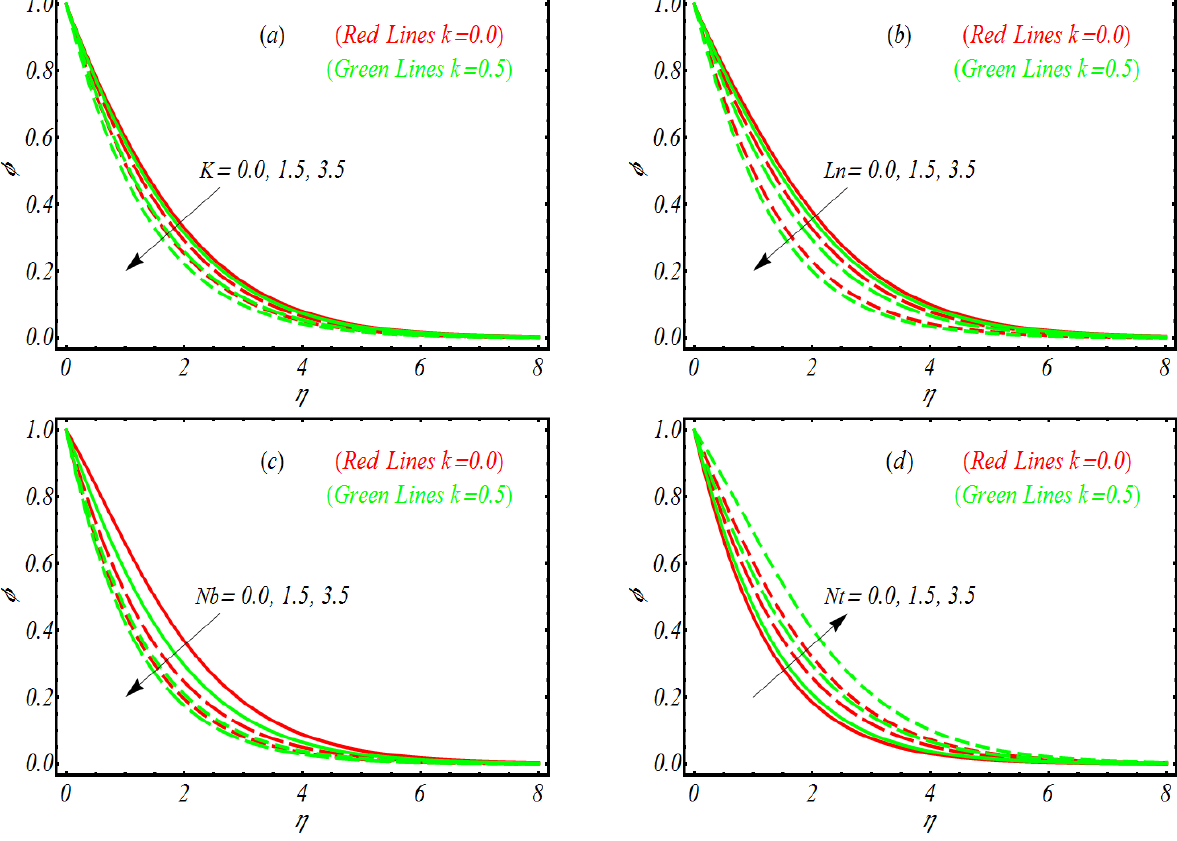
Figure 4. Concentration profile for ( a ) K , ( b ) Ln , ( c ) Nb and ( d ) Nt .